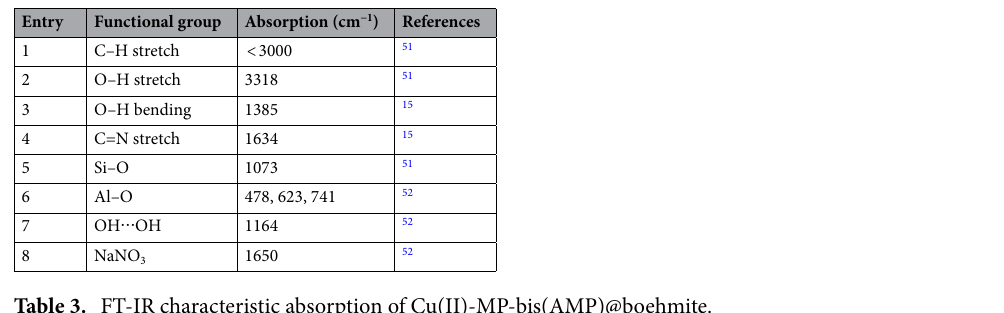
Table 3. FT-IR characteristic absorption of